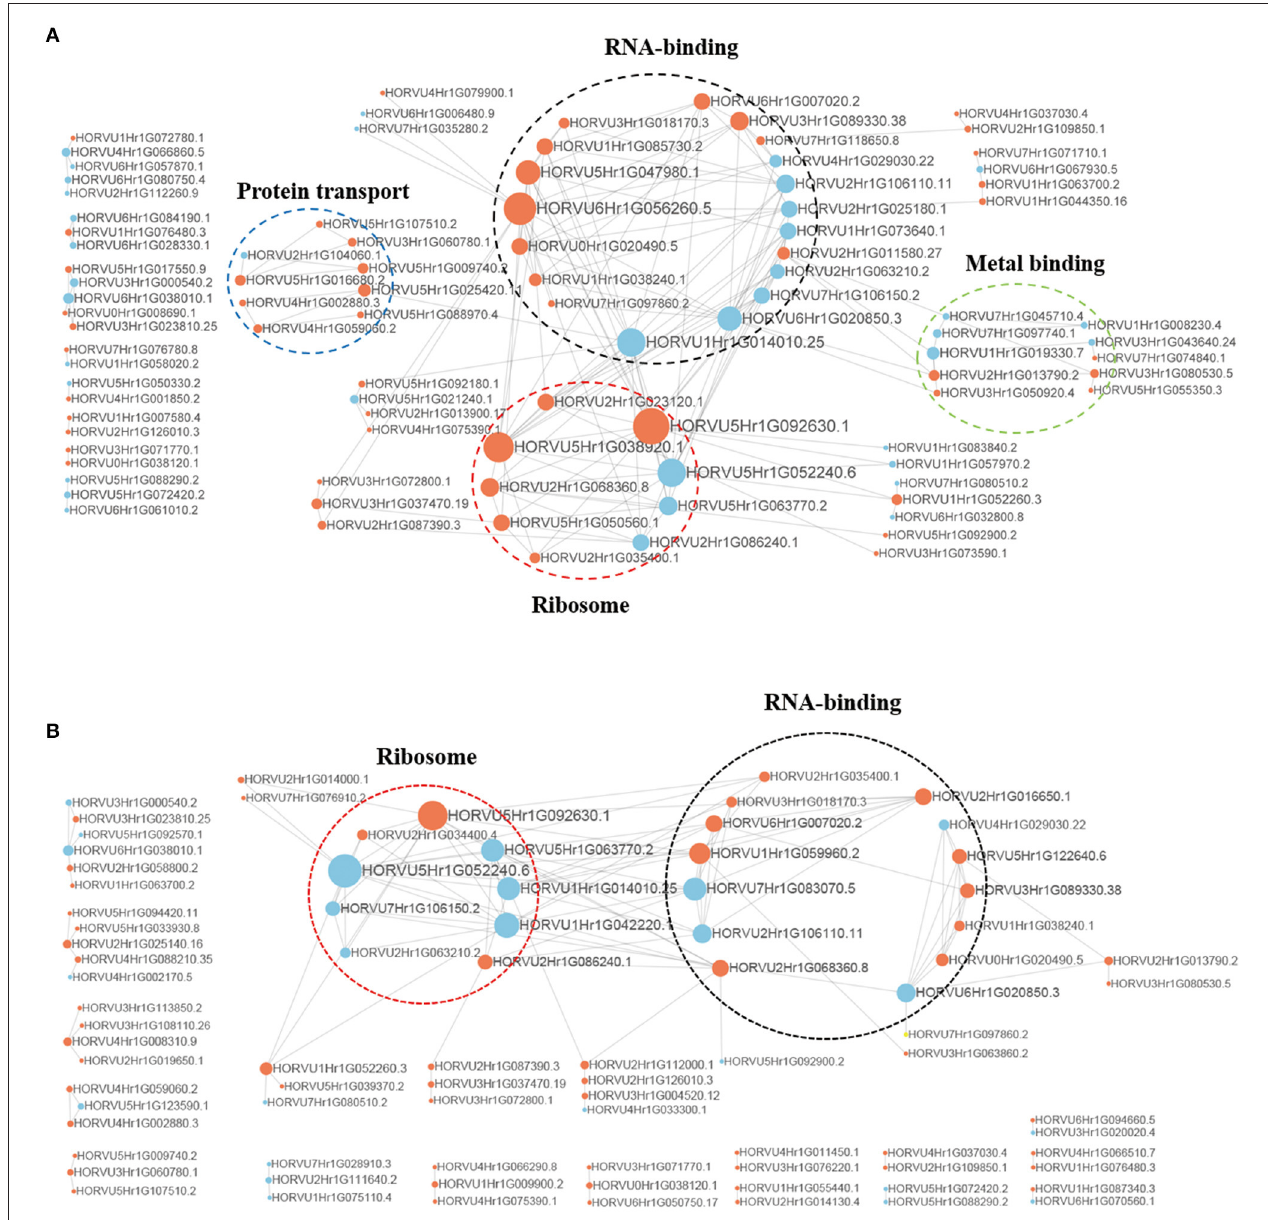
FIGURE 8 | Interaction networks of phosphorylated proteins. (A) The whole PPI network of Pi starvation; (B) the whole PPI network of Pi resupply. Circle size represents the numbers of DPPs, and red indicates upregulated and blue indicates downregulated DPPs. DPPs, differentially phosphorylated proteins; PPI, protein–protein